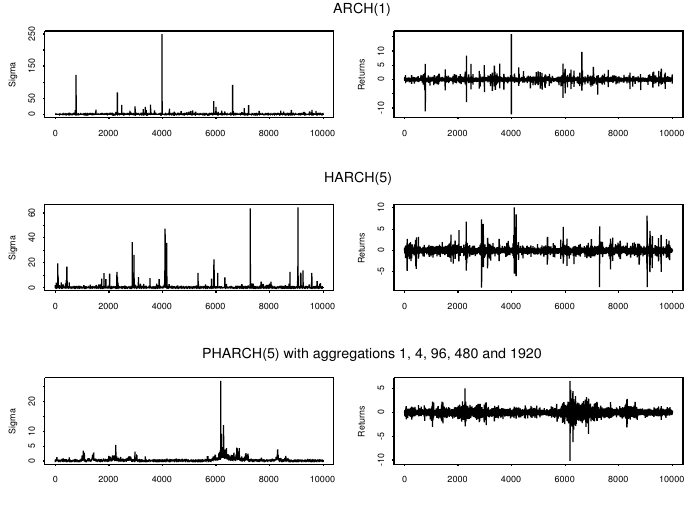
Figure 1. Simulations of ARCH, HARCH and PHARCH